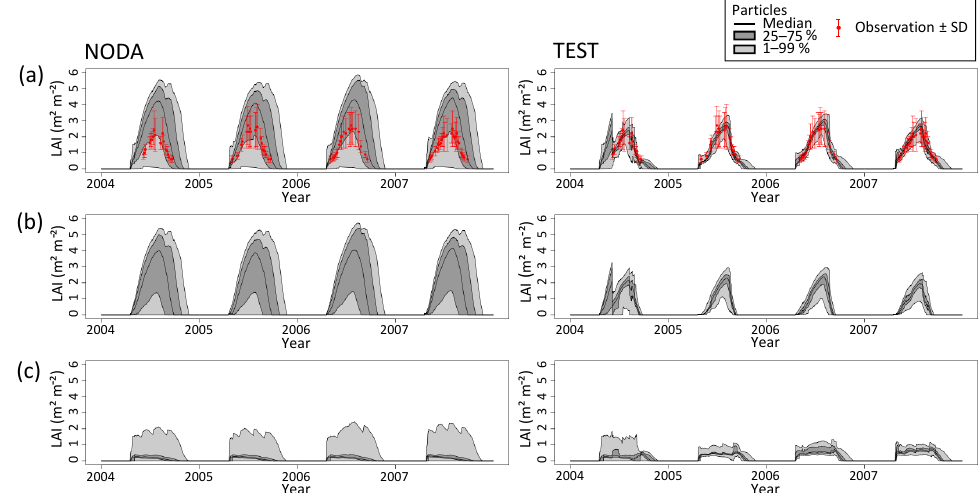
Figure 7. Similar to Fig. 3, showing LAI for (a) tree plus grass, (b) tree, and (c) grass but for the real-world experiment. Red dots with error bars indicate the observations and their error standard deviations.